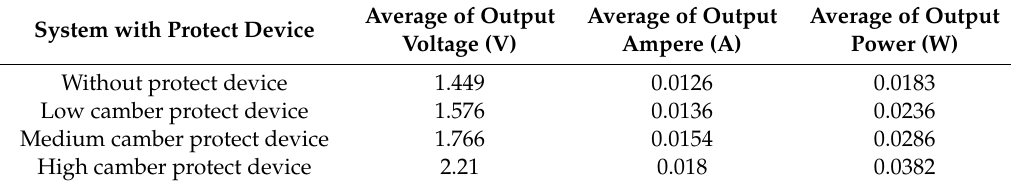
Figure 7. DCPower benefits of different cambers of the PZT protector.( a ) no protector, ( b ) low camber, ( c ) medium camber, ( d ) high camber.